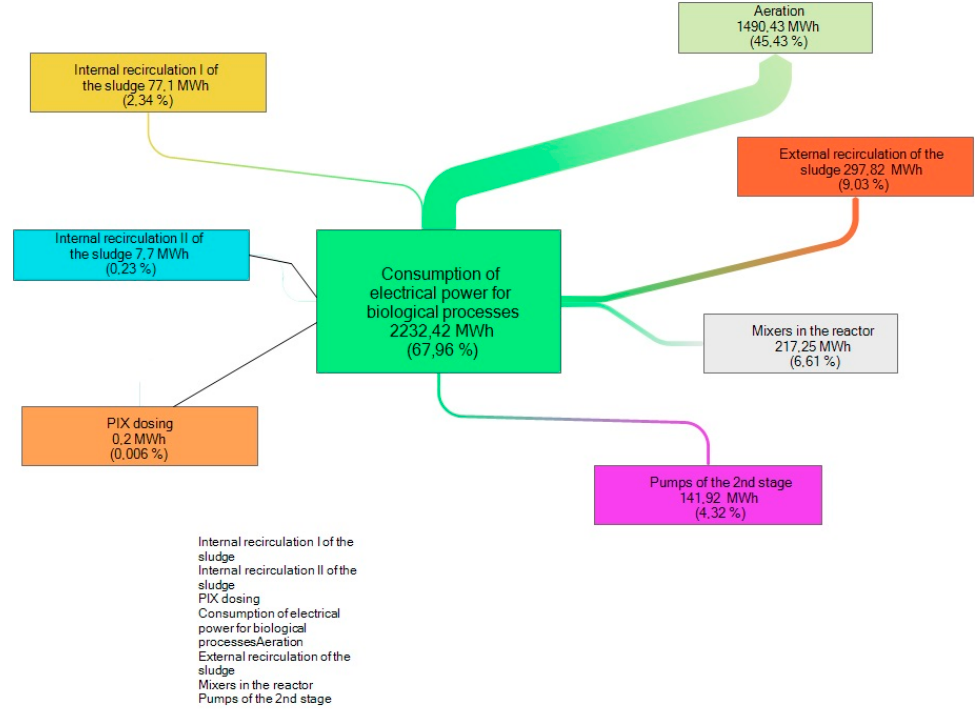
Figure 12. Amount of electricity used exclusively in the biological wastewater treatment process.